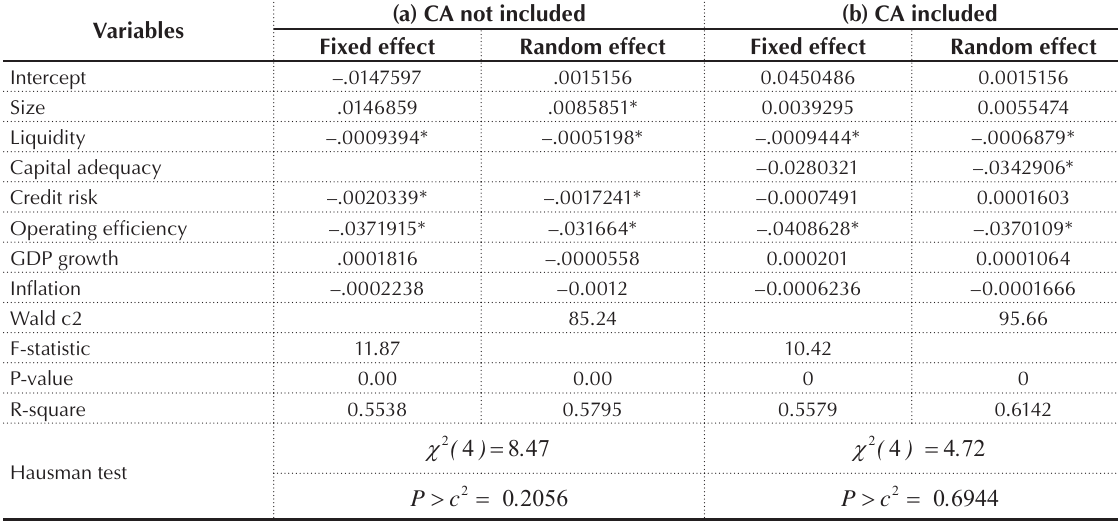
Table (cid:1009). (cid:90)(cid:286)(cid:336)(cid:396)(cid:286)(cid:400)(cid:400)(cid:349)(cid:381)(cid:374)(cid:3)(cid:258)(cid:374)(cid:258)(cid:367)(cid:455)(cid:400)(cid:349)(cid:400)